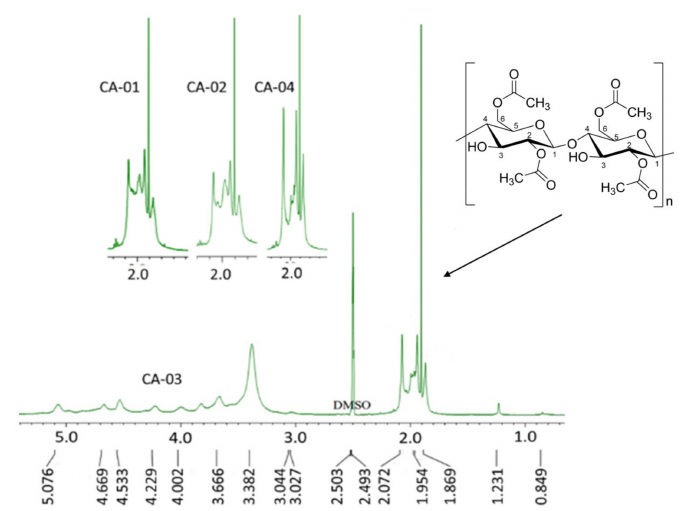
Figure 3. 1 H NMR spectra of CA samples.